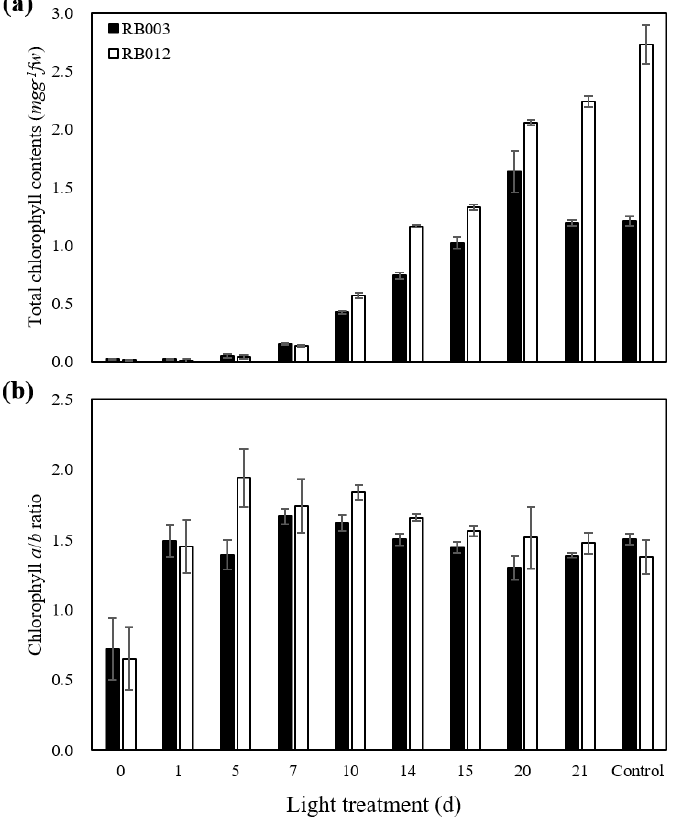
Figure 3. Chlorophyll contents after light treatment in rhizomes of Cymbidium hybrids RB003 and RB012. ( a ) Total chlorophyll contents; ( b ) Chlorophyll a / b ratio. Dark-treated rhizomes were subjected to light treatment. Dark treatment durations were 60 and 75 days for the rhizomes of Cymbidium hybrids RB003 and RB012, respectively.